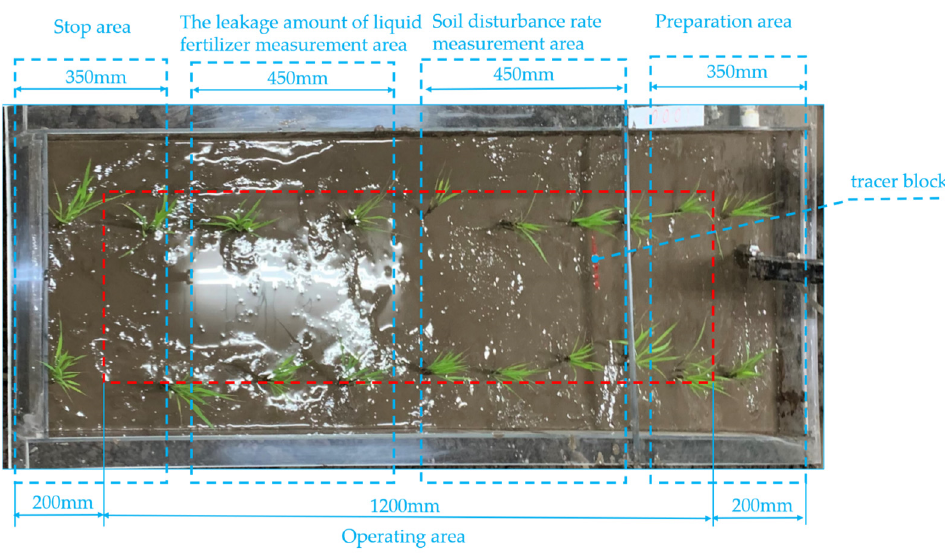
Figure 3. Schematic diagram of the solid soil bin.